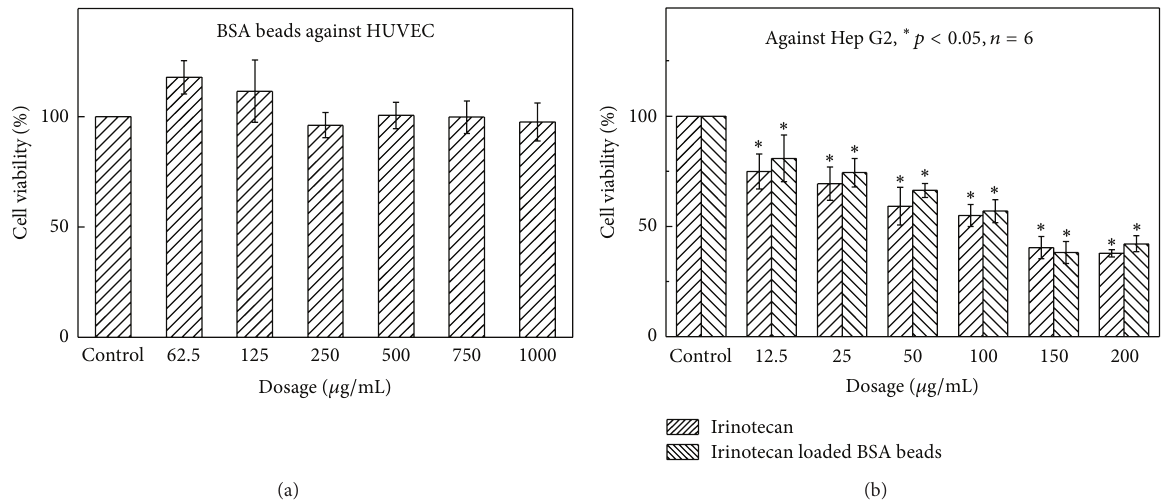
Figure 4: Cytotoxicity of BSA beads against HUVEC (a) and irinotecan loaded BSA beads against Hep G2 (b).